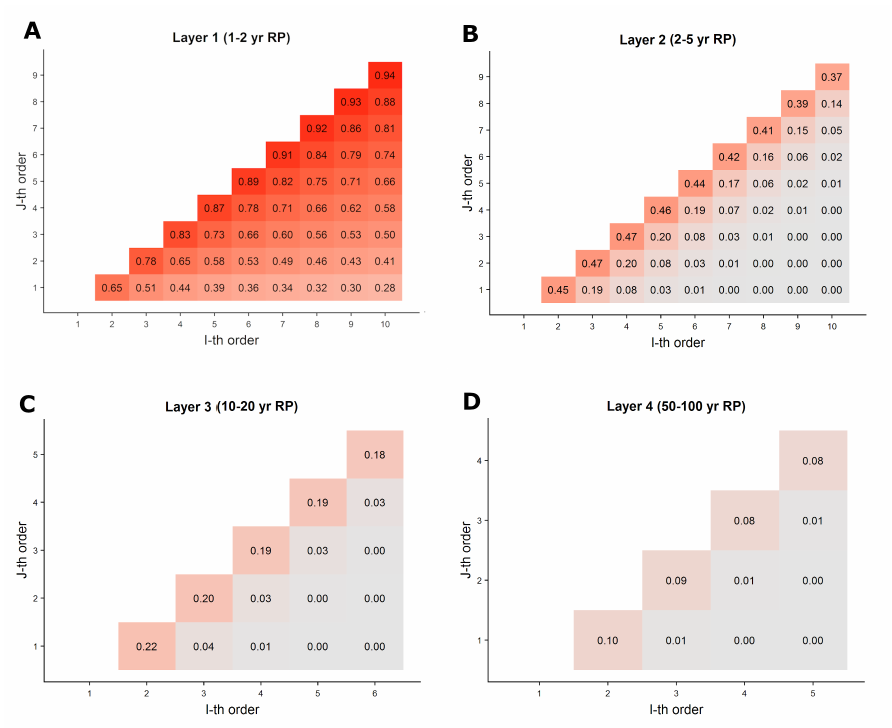
Figure 10. ( Panel A ) depicts the post-catXL correlation structure for Layer 1 (1–2 year return period). ( Panels B – D ) depicts the correlation structure for Layers